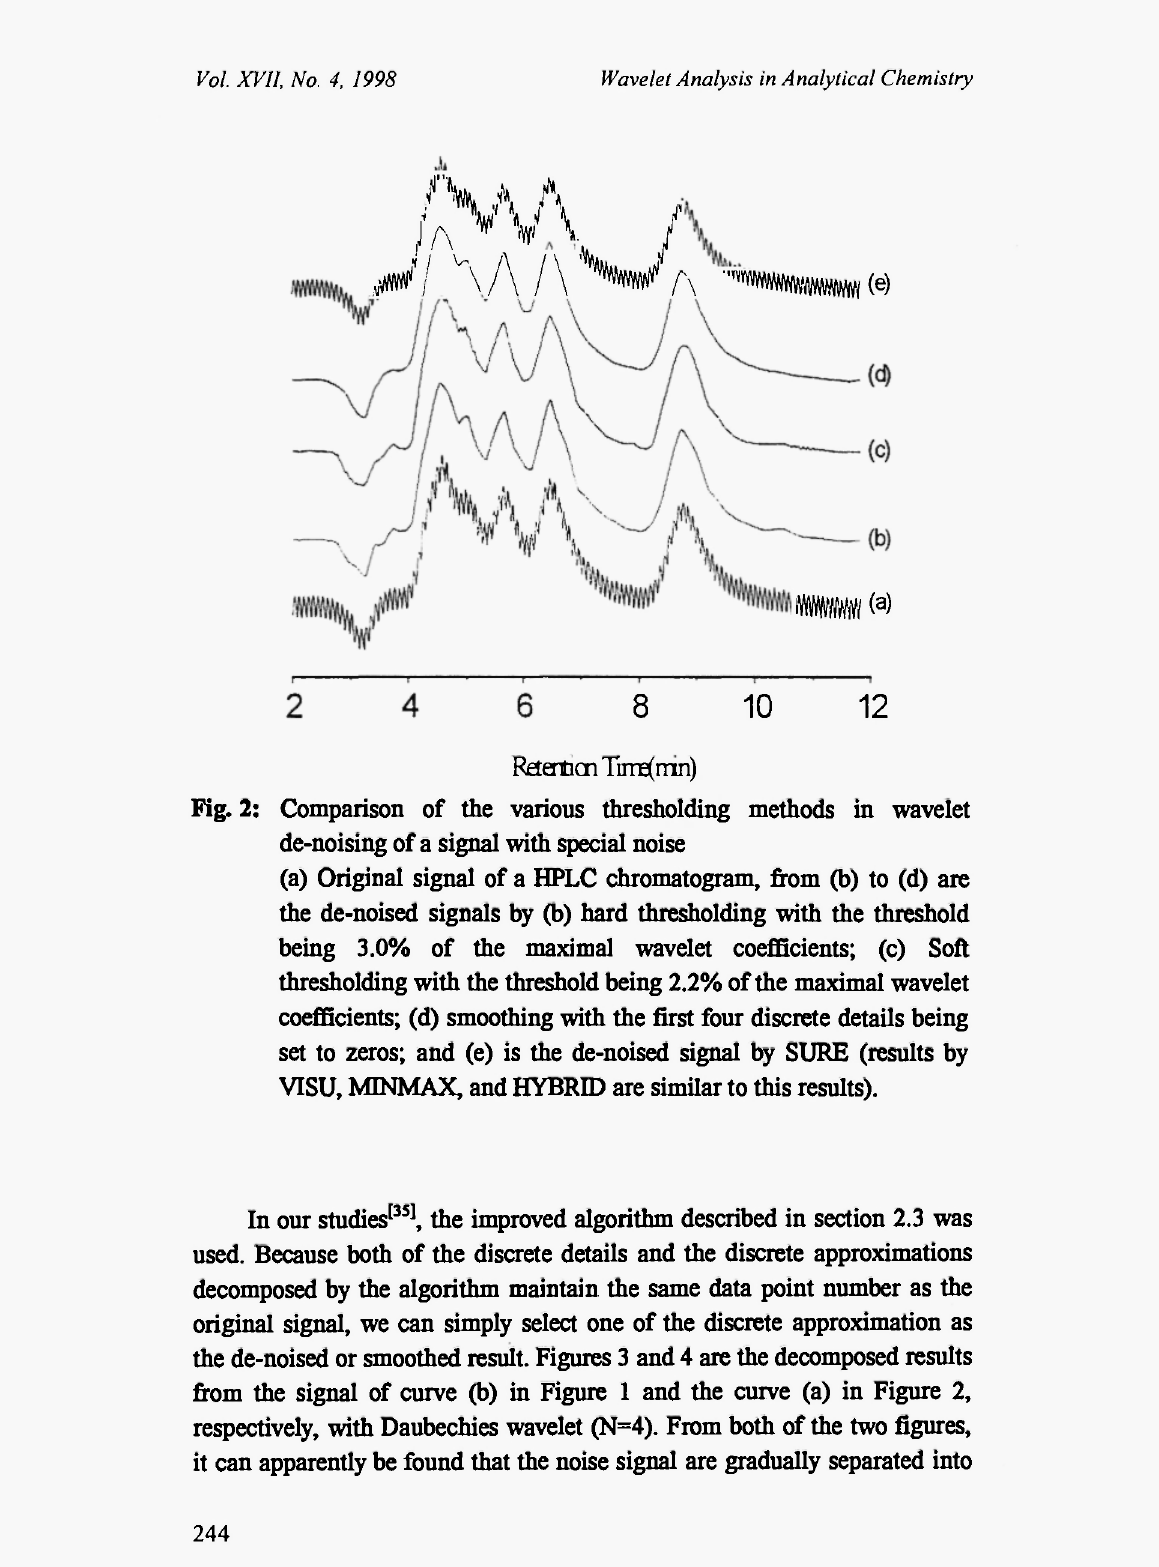
Fig. 2: Comparison of the various thresholding methods in wavelet de-noising of a signal with special noise (a) Original signal of a HPLC chromatogram, from (b) to (d) are the de-noised signals by (b) hard thresholding with the threshold being 3.0% of the maximal wavelet coefficients; (c) Soft thresholding with the threshold being 2.2% of the maximal wavelet coefficients; (d) smoothing with the first four discrete details being set to zeros; and (e) is the de-noised signal by SURE (results by VISU, MINMAX, and HYBRID are similar to this